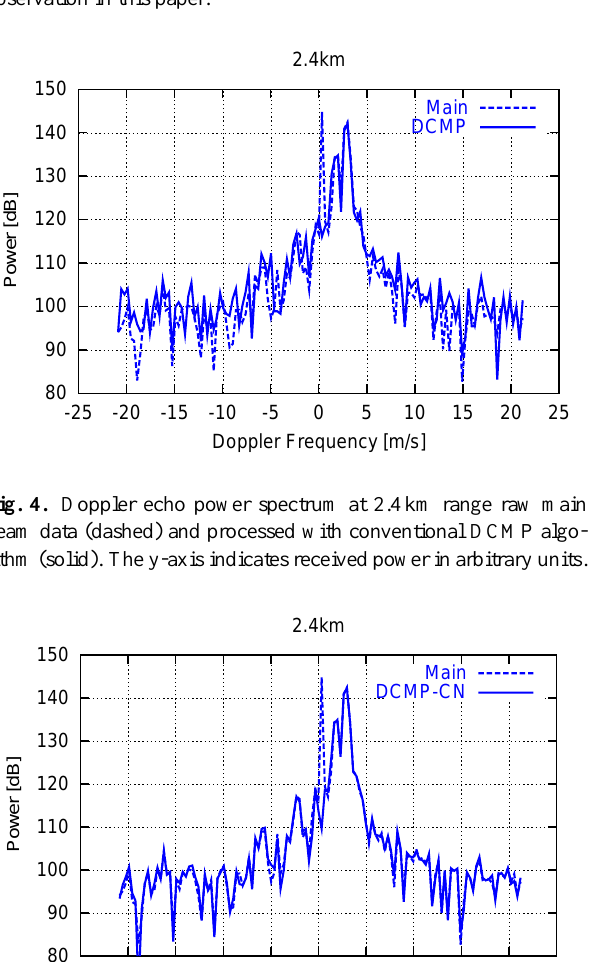
Fig. 3. Antenna field configuration and antenna positions for the observation in this paper.